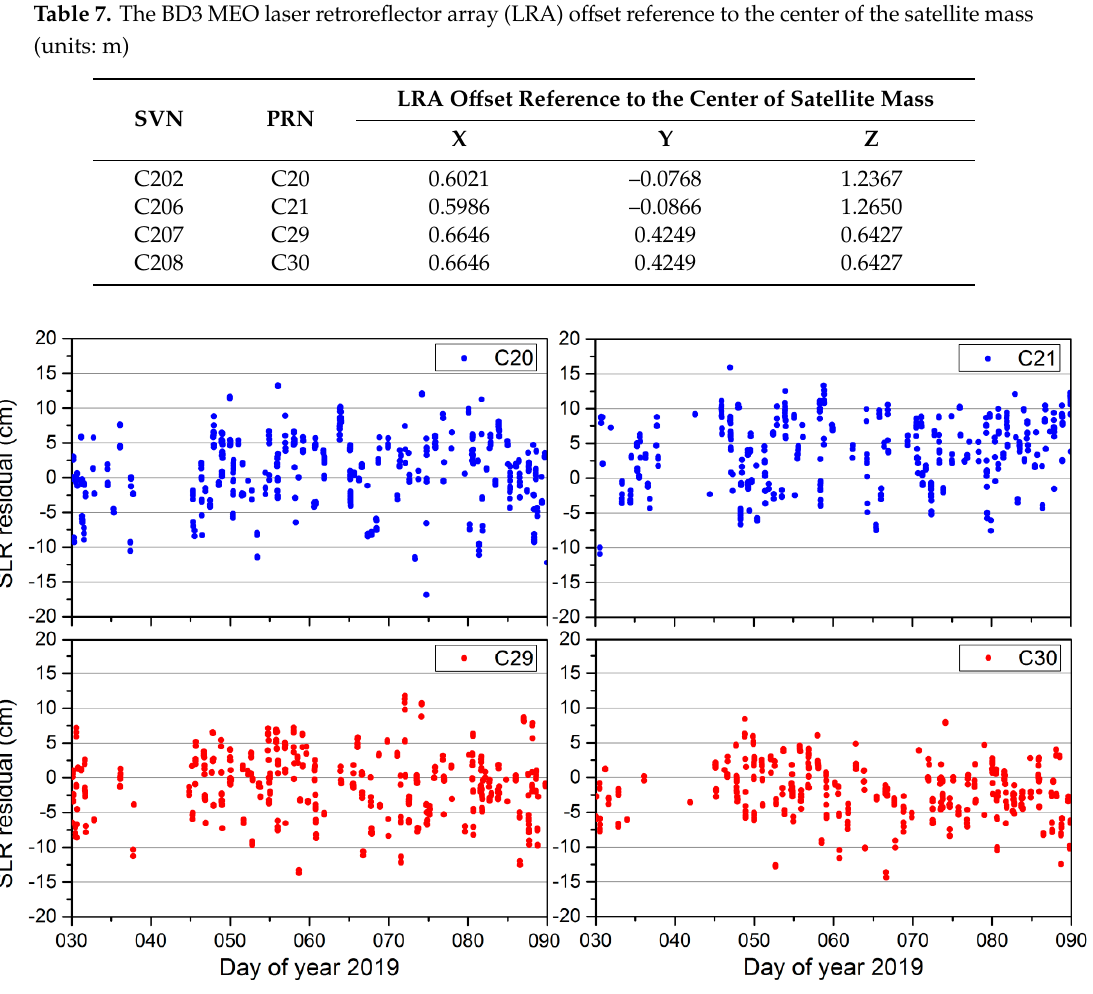
Table 7. The BD3 MEO laser retroreflector array (LRA) offset reference to the center of the satellite mass (units: m)